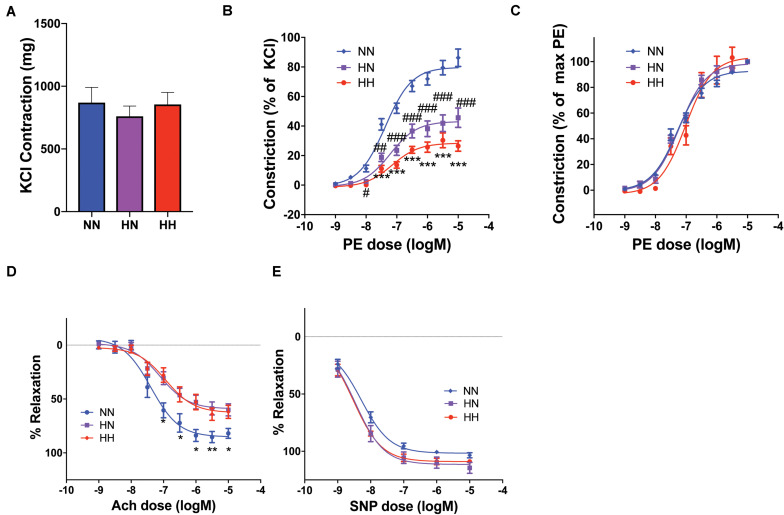
Aortic vasoreactivity is impaired by hypertension despite restoration of blood pressure. (A) The maximal contraction response to potassium chloride (KCl) was similar in the three groups (n = 8 mice per cohort). (B) Contraction response to increasing phenylephrine (PE) concentrations calculated as a percent of maximal KCl-induced contraction was significantly impaired in the HH cohort and modestly better in the HN cohort (n = 8 mice per cohort; ∗∗∗p < 0.001 for HH vs. NN and HH vs. HN; #p < 0.05, ##p < 0.01, ###p < 0.001 vs. NN by ordinary 2-way ANOVA with Bonferroni post hoc analysis). (C) EC50 of the cohorts remained similar, as shown by the PE contractile responses normalized to maximal PE contraction for each sample. (D) The endothelium-dependent vasodilatory response of PE-pre-constricted vessels to increasing concentrations of acetylcholine (Ach) was impaired in both HN and HH cohorts (n = 8 mice per cohort; ∗p < 0.05, ∗∗p < 0.01 for NN vs. HN and NN vs. HH by ordinary 2-way ANOVA with Bonferroni post hoc analysis). (E) Endothelium-independent vasorelaxation in response to increasing concentrations of sodium nitroprusside (SNP) was similar in all groups (n = 8 mice per cohort).